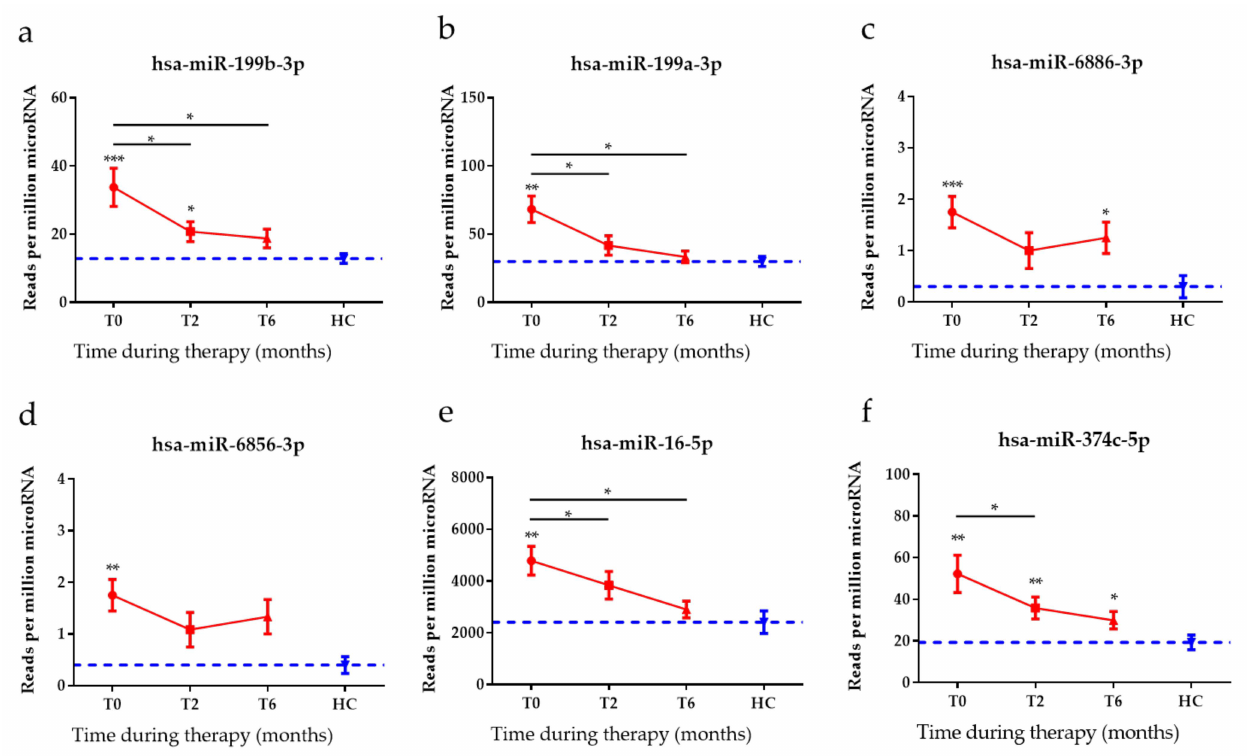
Figure 3. The expression levels of the top six miRNAs in patients with active tuberculosis (ATB) before, during and after treatment. The expression levels of ( a ) miR-199b-3p, ( b ) miR-199a-3p, ( c ) miR-6886-3p, ( d ) miR-6856-3p, ( e ) miR-16-5p, and ( f ) miR-374c-5p were measured in patients with ATB collected at the time of diagnosis (T0), after two months of therapy (T2), and after the completion of therapy (T6; 6–9 months after T0). The blue dotted line is representative of the mean miRNA expression level of the healthy control (HC) patients. The data are shown as mean ± standard error of the mean. * p < 0.05, ** p < 0.001, *** p <